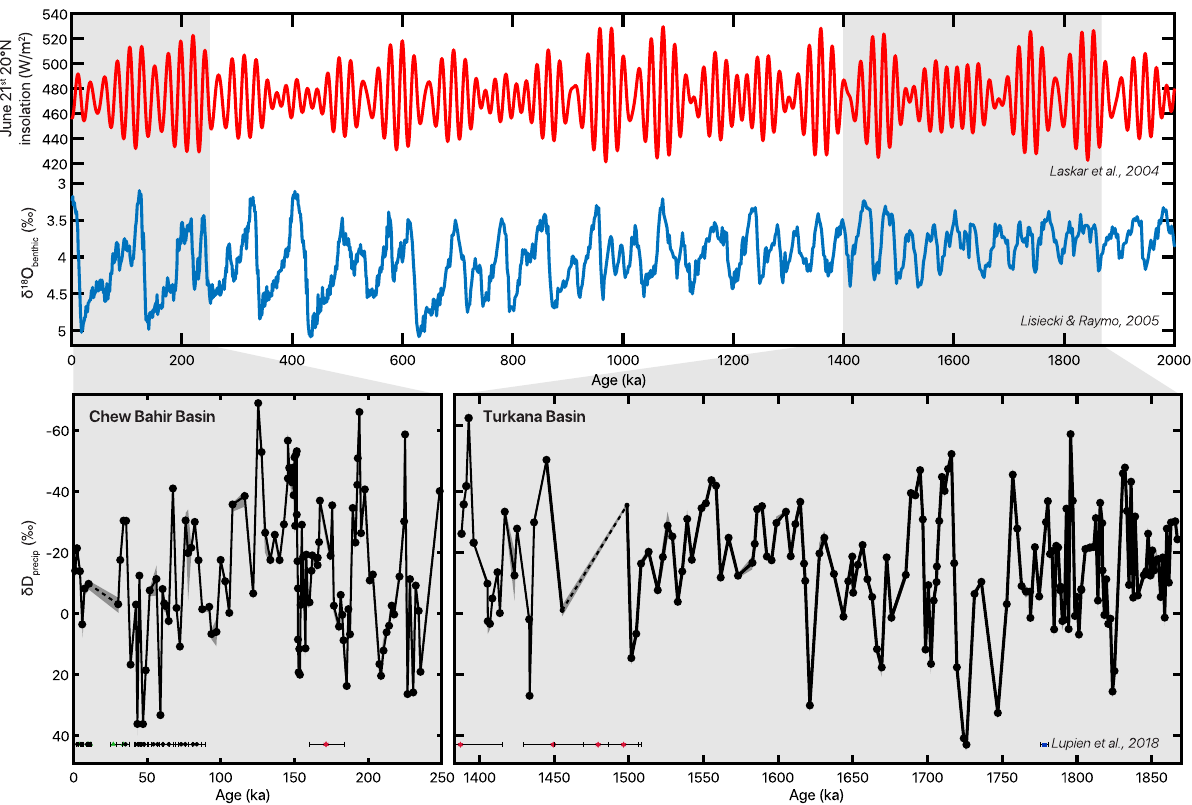
Figure 2. δD precip records corrected for vegetation, ice volume, and geographic effects (Fig. S4) from CHB14-2 and WTK13 in the context of two million years of zonal mean 20° N June 21st insolation 65 (red) and the benthic foraminifera δ 18 O stack 32 (blue). Sampling gaps greater than half of a precession cycle (~10 kyr) are represented with dashed lines and analytical error on δD wax measurements in shading. Age constraints for CHB14-2 and WTK13 24,45 with 1σ analytical error depicted along bottom with symbol indicating dating technique (green triangle = 14 C; black circle = OSL; red star = 40 Ar/ 39 Ar; blue square =